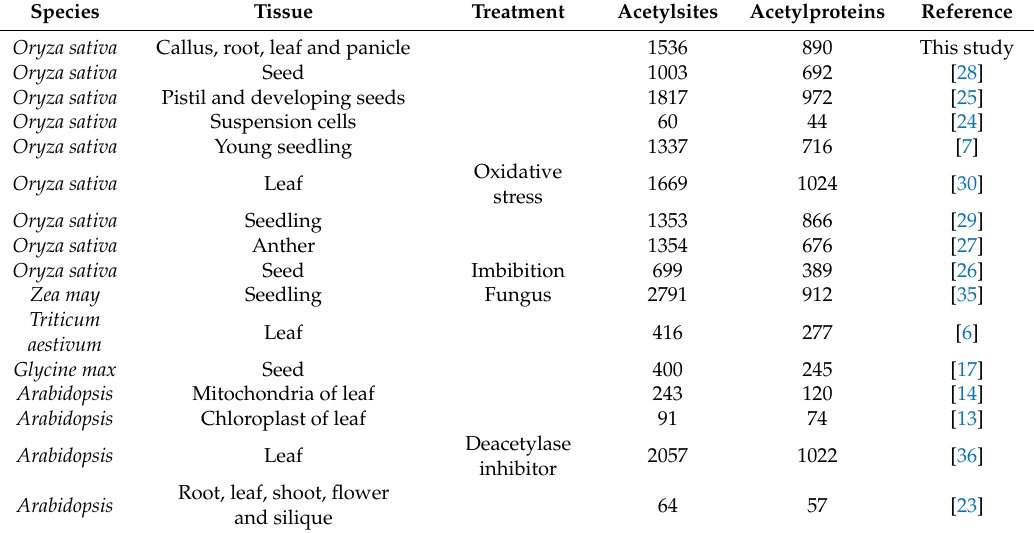
Table 2. Summary of the reported acetylome identification cases in rice and other plant